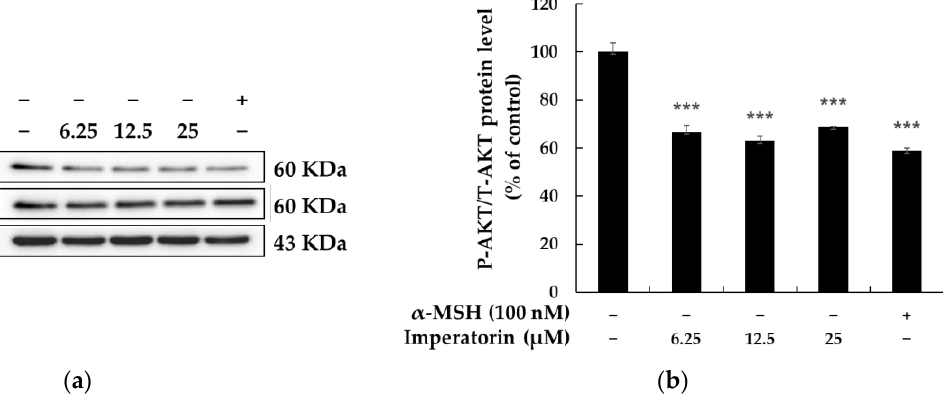
Figure 7. The effects on the protein expression of AKT in B16F10 melanoma cells when the cells were treated with imperatorin (25, 12.5 and 6.25 μM) for 4 h: ( a ) Western blotting results; ( b ) protein levels of MITF. β -Actin was used as a loading control. The results are presented as the mean ± SD from three independent measurements using ImageJ software. *** p < 0.001 vs. the untreated control group.